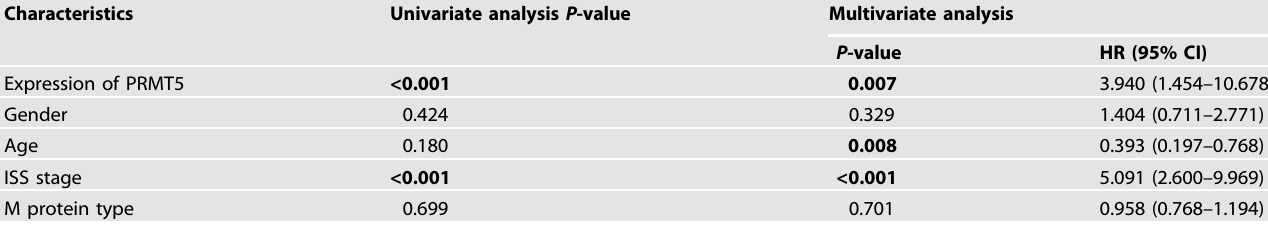
Table 2. Univariate and multivariate analyses of clinicopathological characteristics for survival in patients with MM.